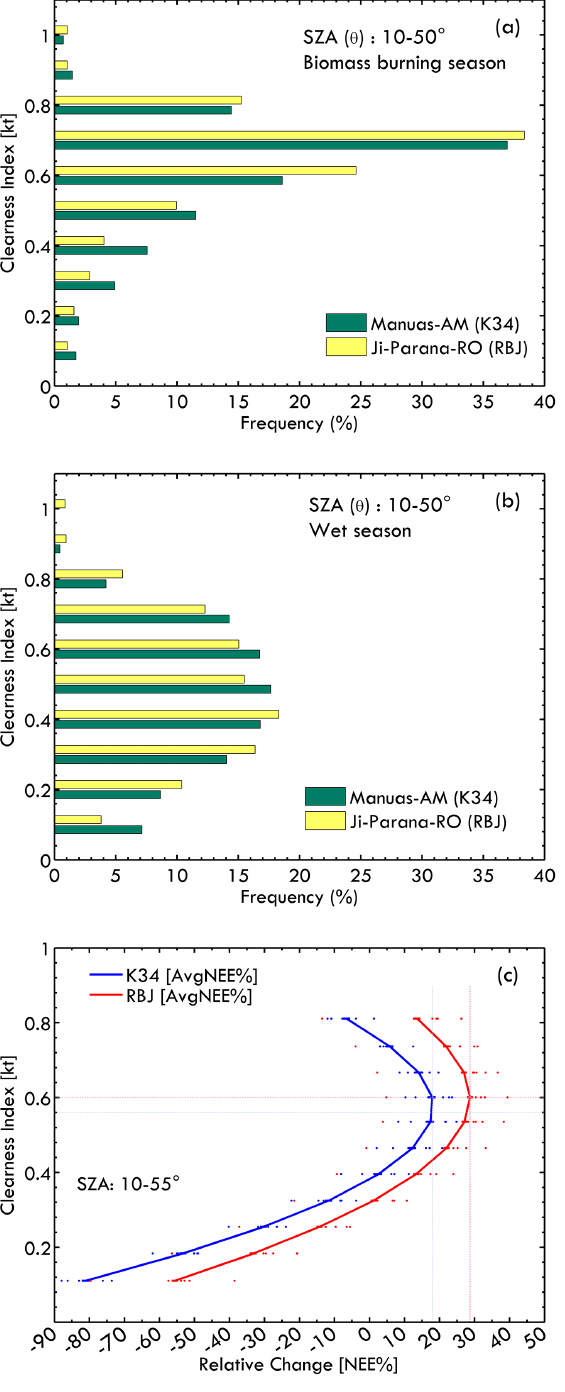
Figure 10. Histograms of values of the clearness index for K34 and RBJ along the biomass burning season (a) and wet season (b) . The limit at which the cloudiness and/or aerosol load result in the max- imum carbon uptake at RBJ and K34 are shown in (c) . The relative change values (NEE(%)) were calculated for solar zenithal angles between 10 ◦ and